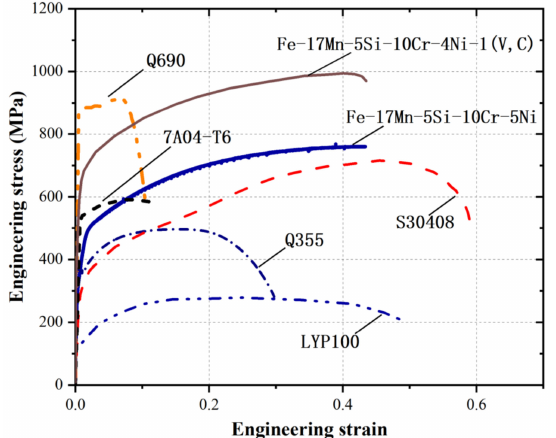
Figure 3. Typical full stress-strain curves of Fe-SMA and other typical structural steels